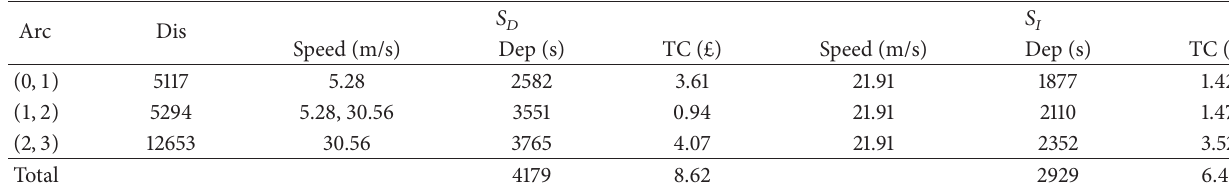
Table 2: Results in Example 2.